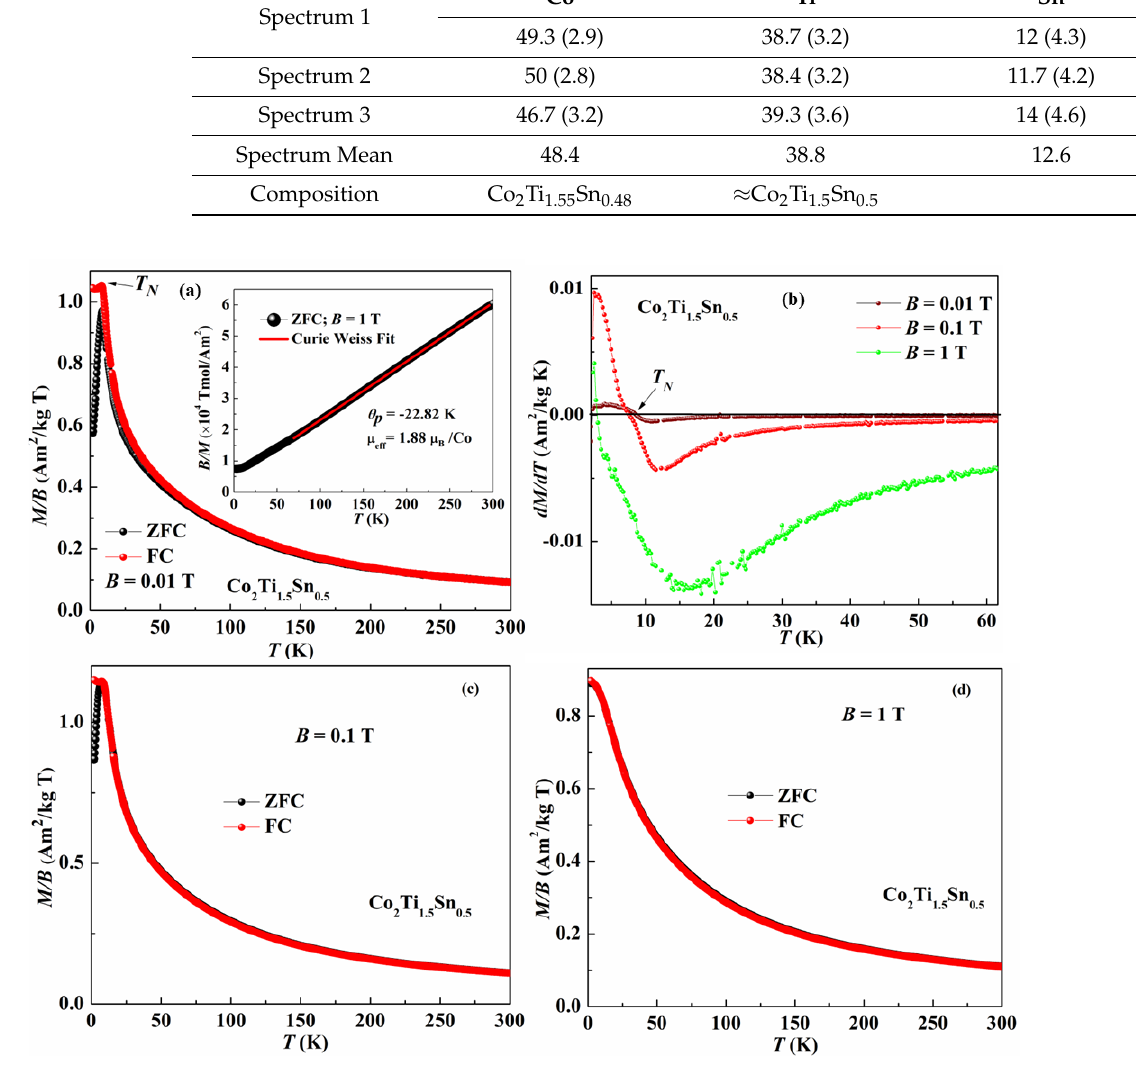
Figure 2. ( a ) Variation in magnetic susceptibility ( M/B(T) ) with temperature in an applied magnetic field of B = 0.01 T. The linear fit of Equation (1) is shown in the inset. ( b ) First-order derivative of ZFC magnetization with temperature for the applied magnetic fields of B = 0.01 T, 0.1 T, and 1 T. ZFC and FC M/B(T) in an applied magnetic field of B = 0.1 T ( c ) and 1 T ( d ). The inset of Figure 2a depicts the Curie – Weiss behavior of the alloy in a temperature range of 80 – 300 K at B = 1 T, obeying the Eq . (1)